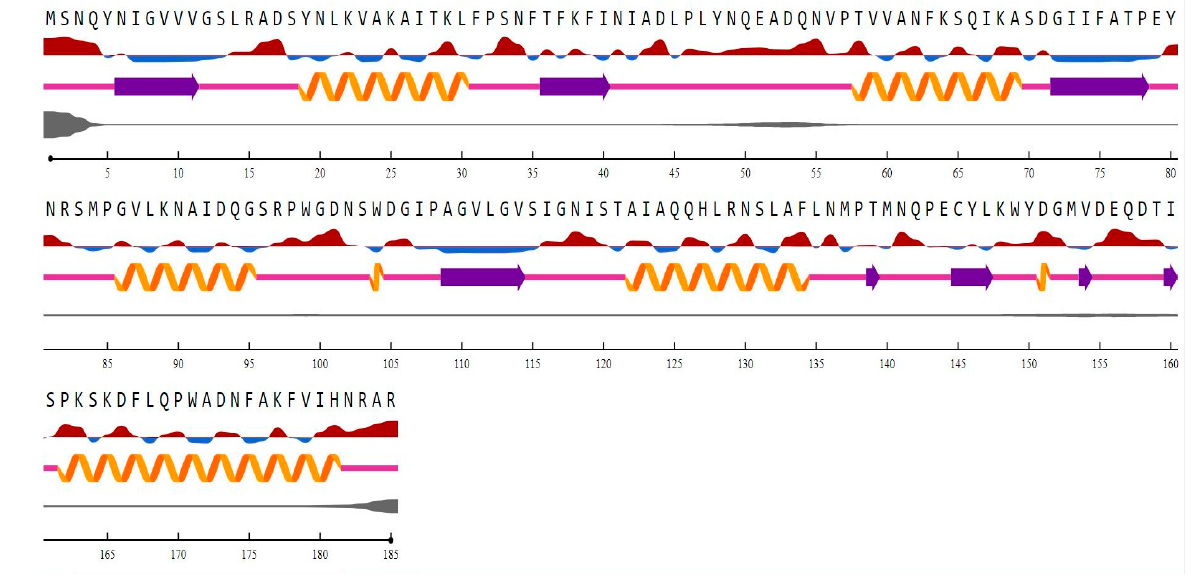
Figure 4. Jpred and Netsurf P analysis of ChrR ( P. alcalifaciens ) secondary structure where helices are shown in yellow spirals, sheets in purple arrows, and coils in magenta lines. The letters denote amino acids. The exposed and buried residues are shown in red and blue colored lines, respectively. The disordered regions are determined by the thickness of the gray-colored line.